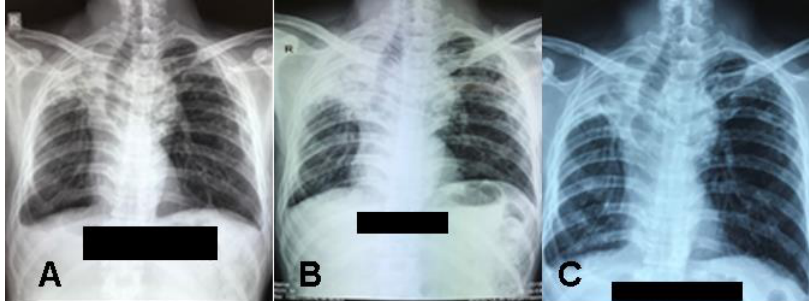
Figure 2. A. Follow-up Chest X-ray after chest tube with Heimlich valve in 22 days; B. Chest X-ray before removing Heimlich valve 60 days after chest tube insertion, left lung fully expanded; C. Chest X-ray after completing six months of therapy for pulmonary